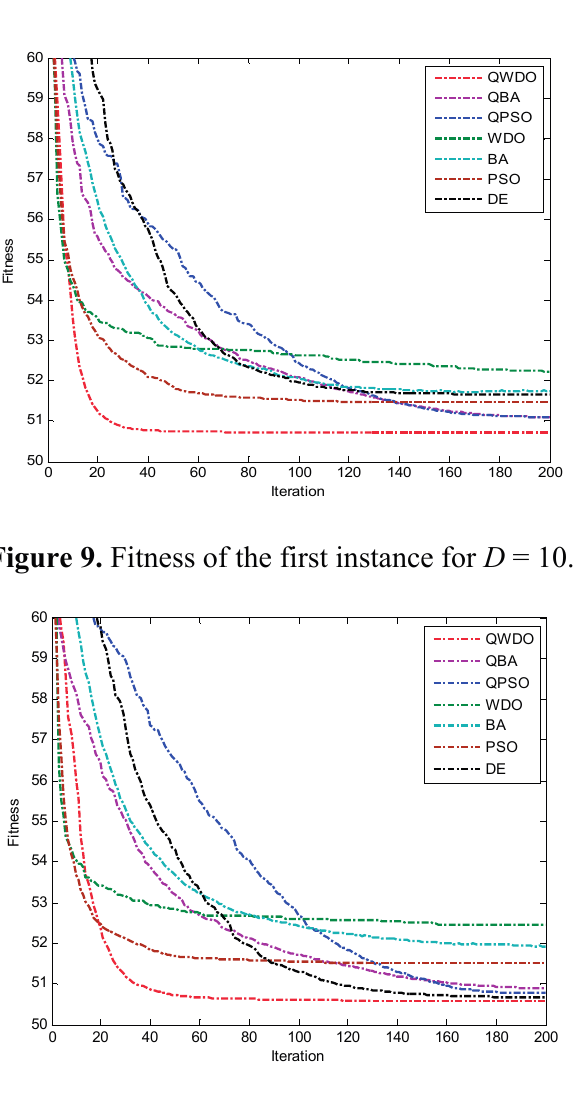
Figure 10. Fitness of the first instance for D =